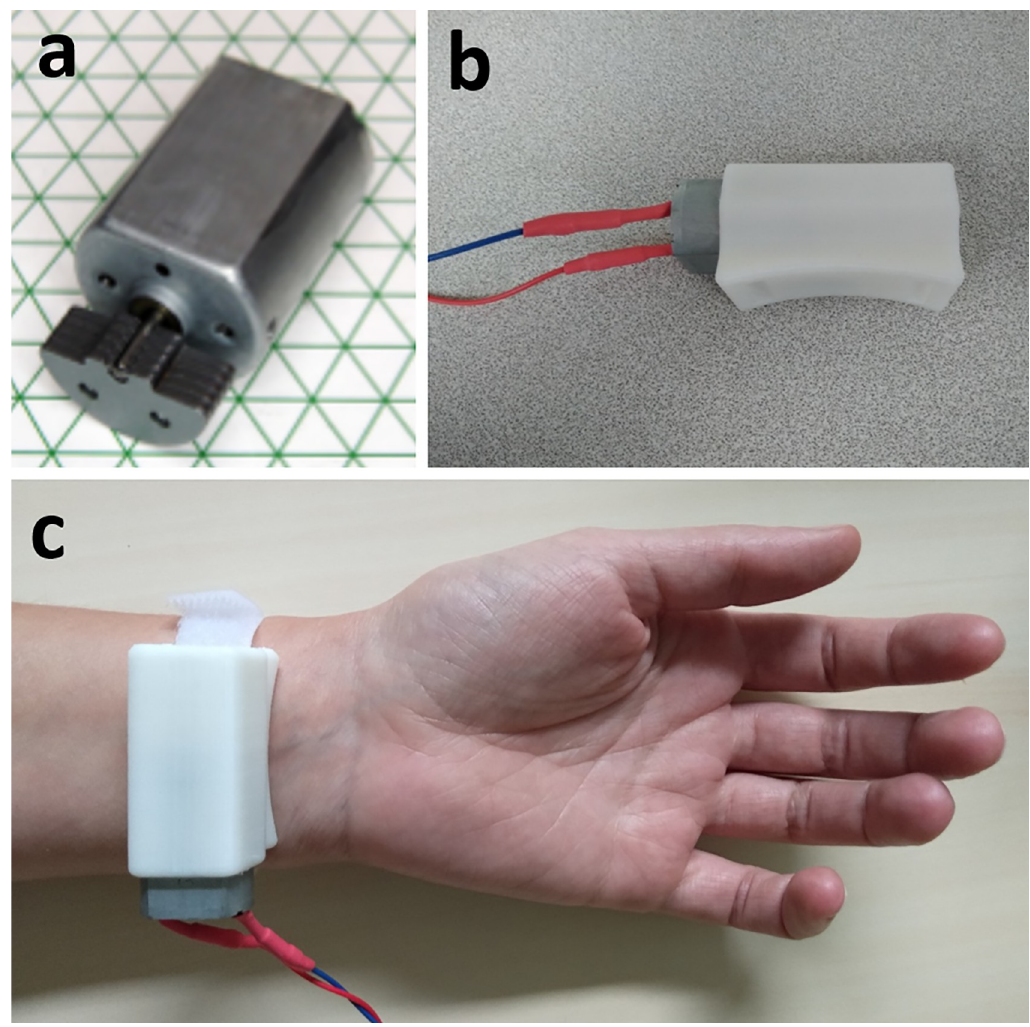
Fig 3. Pictures of the vibratory device UniVibe ™ . a) Raw vibration motor. b) Vibration motor device linked to the Arduino 1 and inside a sound box. c) Wrist